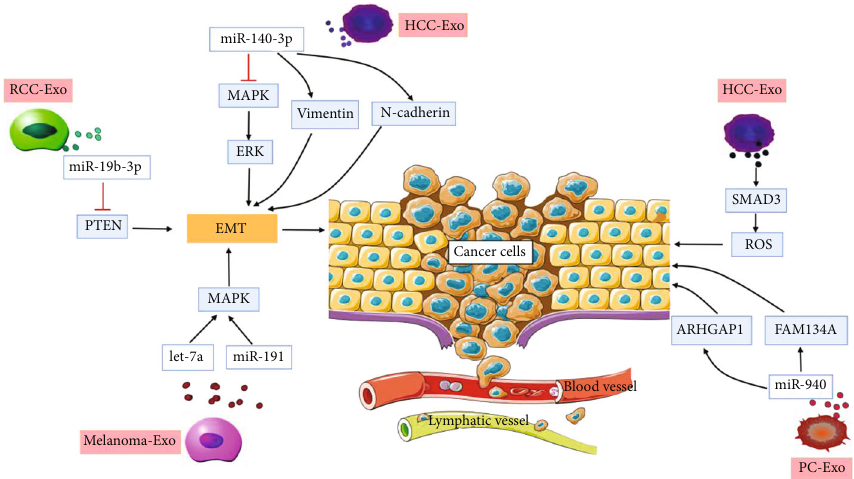
Figure 3: CSC-Exos are involved in cancer metastasis and in fi ltration. Exosomes derived from renal clear carcinoma (RCC) stem cells carry miR-19b-3p, which inhibits the expression of PTEN in the cell and mediates epithelial-mesenchymal transition (EMT) to promote cancer metastasis. Melanoma cell-derived exosomes carry let-7a and miR-191, which activate MAPK signaling to mediate EMT to promote metastasis. miR-140-3p in exosomes secreted by hepatocellular carcinoma (HCC) cells can inhibit MAPK/ERK pathway activity and increase the expression of vimentin and N-cadherin to induce EMT and tumor metastasis. Primary hepatocellular carcinoma (HCC) cell- derived exosomes facilitate metastasis by regulating adhesion of circulating tumor cells and inducing reactive oxygen species (ROS) production via SMAD3 signaling in liver cancer. Exosomes secreted by prostate cancer (PC) cells contain miR-940, which acts on ARHGAP1 and FAM134A in osteoblasts to promote the formation of a bone metastatic microenvironment.